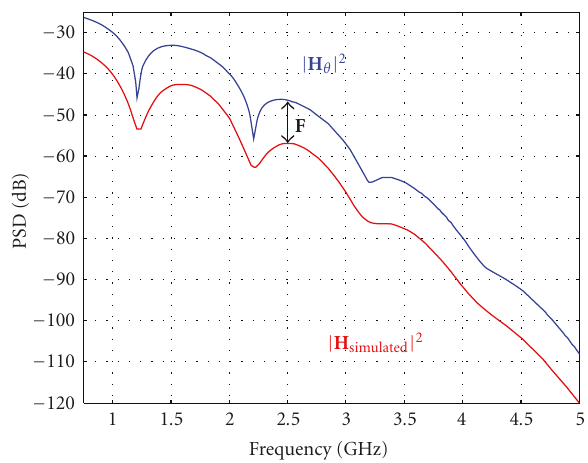
Figure 2: The model H θ based on planar propagation M R combined with the cylinder response C r compared with simulation results. Using a flat factor of F = 10, the two PSDs practically overlap, although the model has deeper troughs and more lopsided peaks. The figure is based on results in